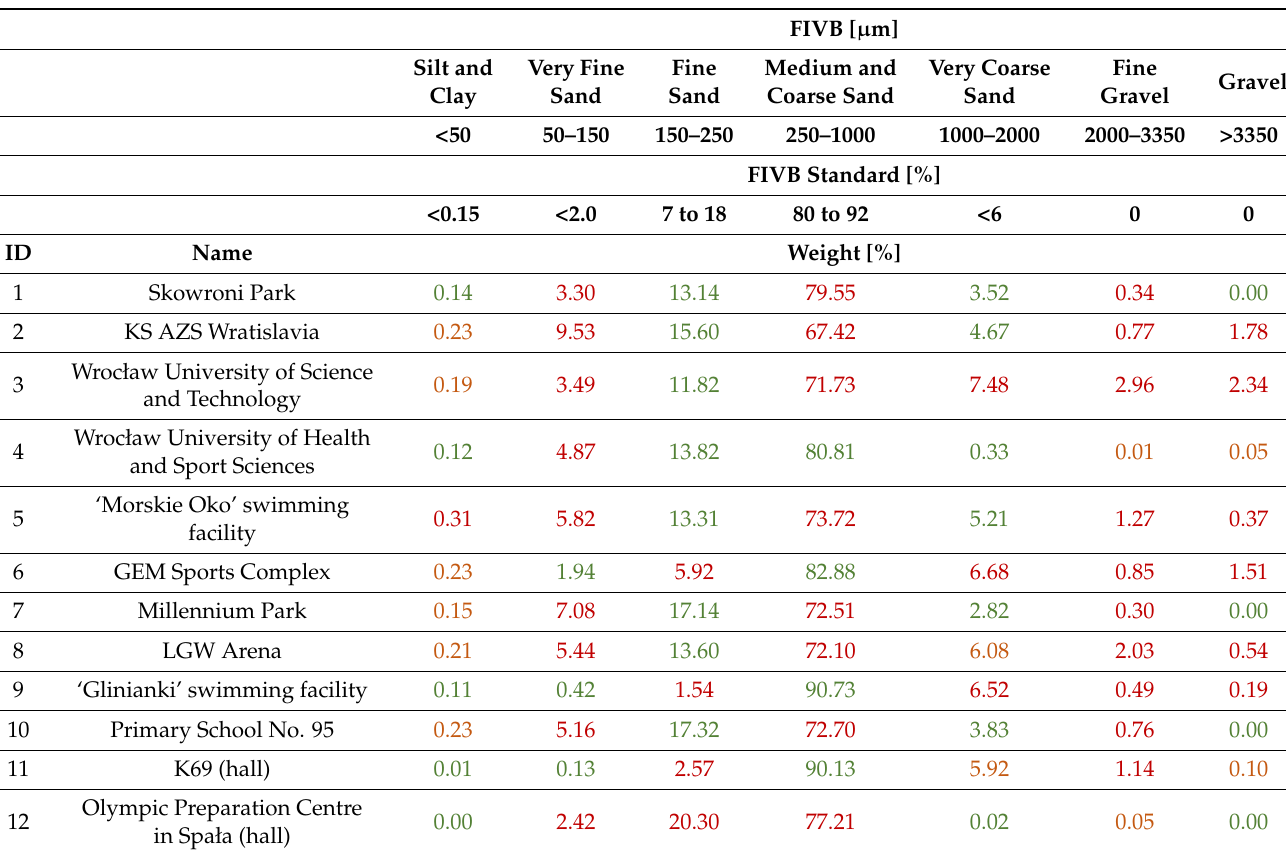
Table 4. Conformity of samples with FIVB grain size standards [7]. Green—standard complied;